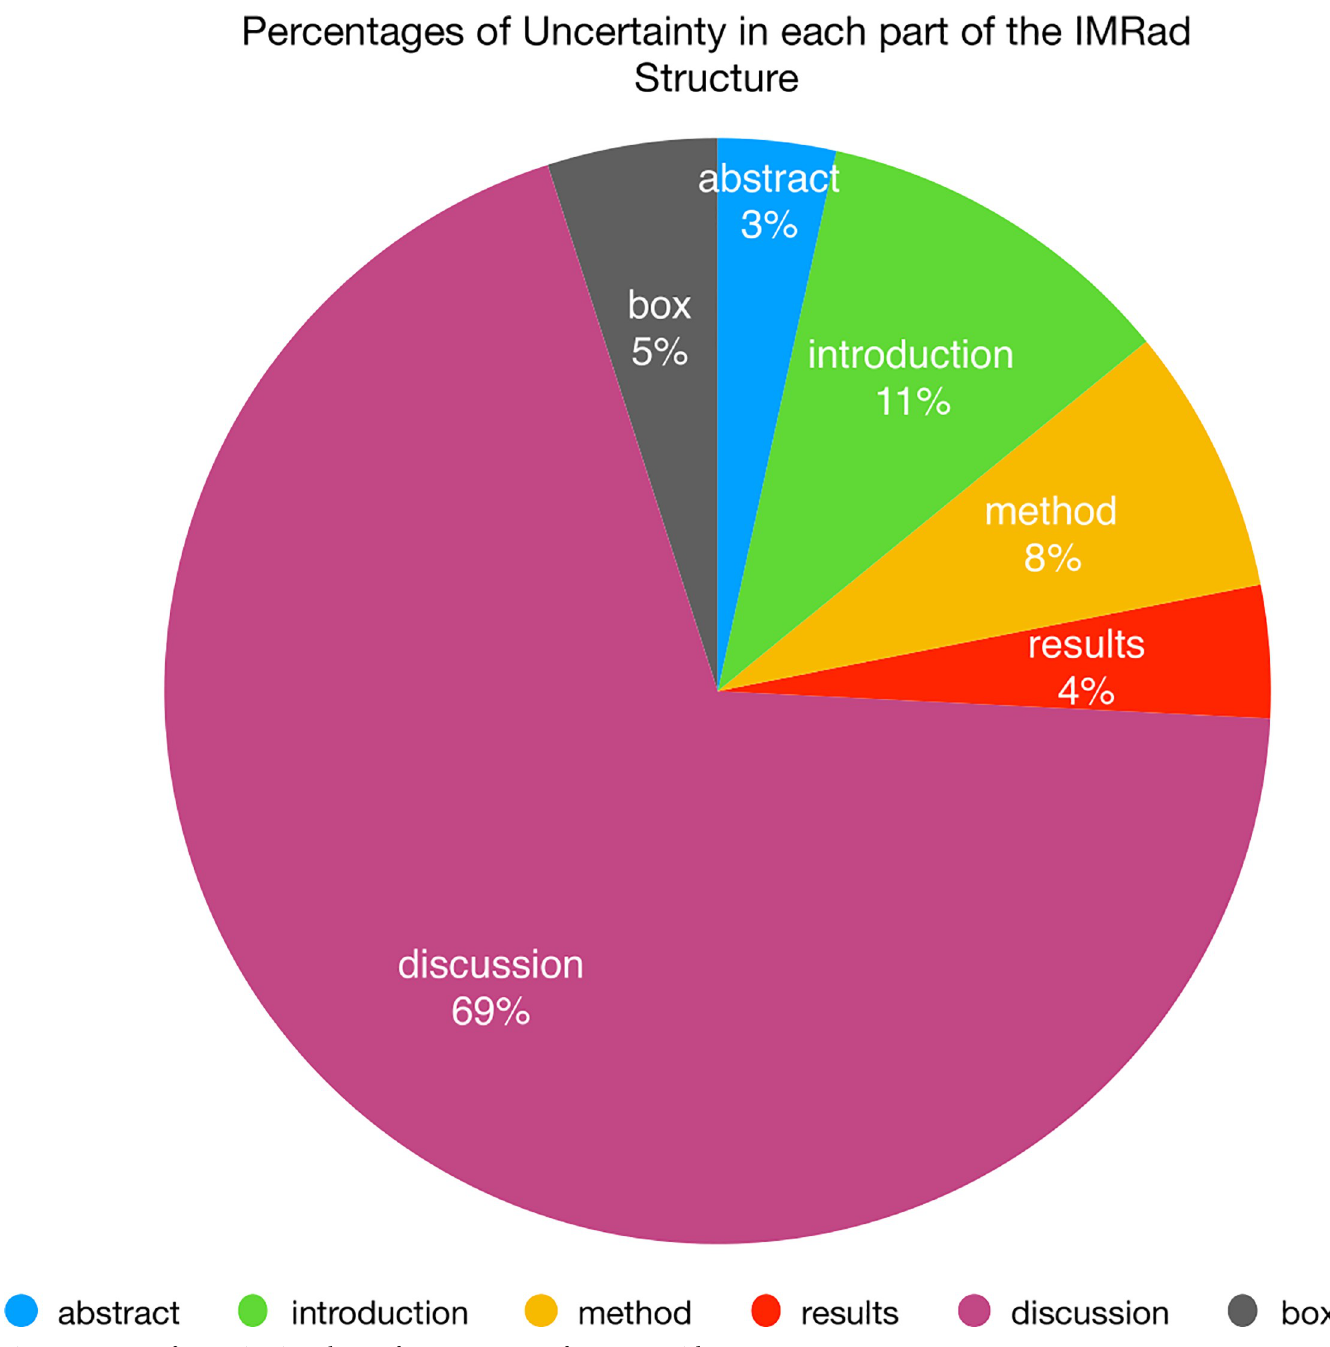
Fig 4. Percentages of uncertainty in each part of IMRaD structure of BMJ 2013 articles.